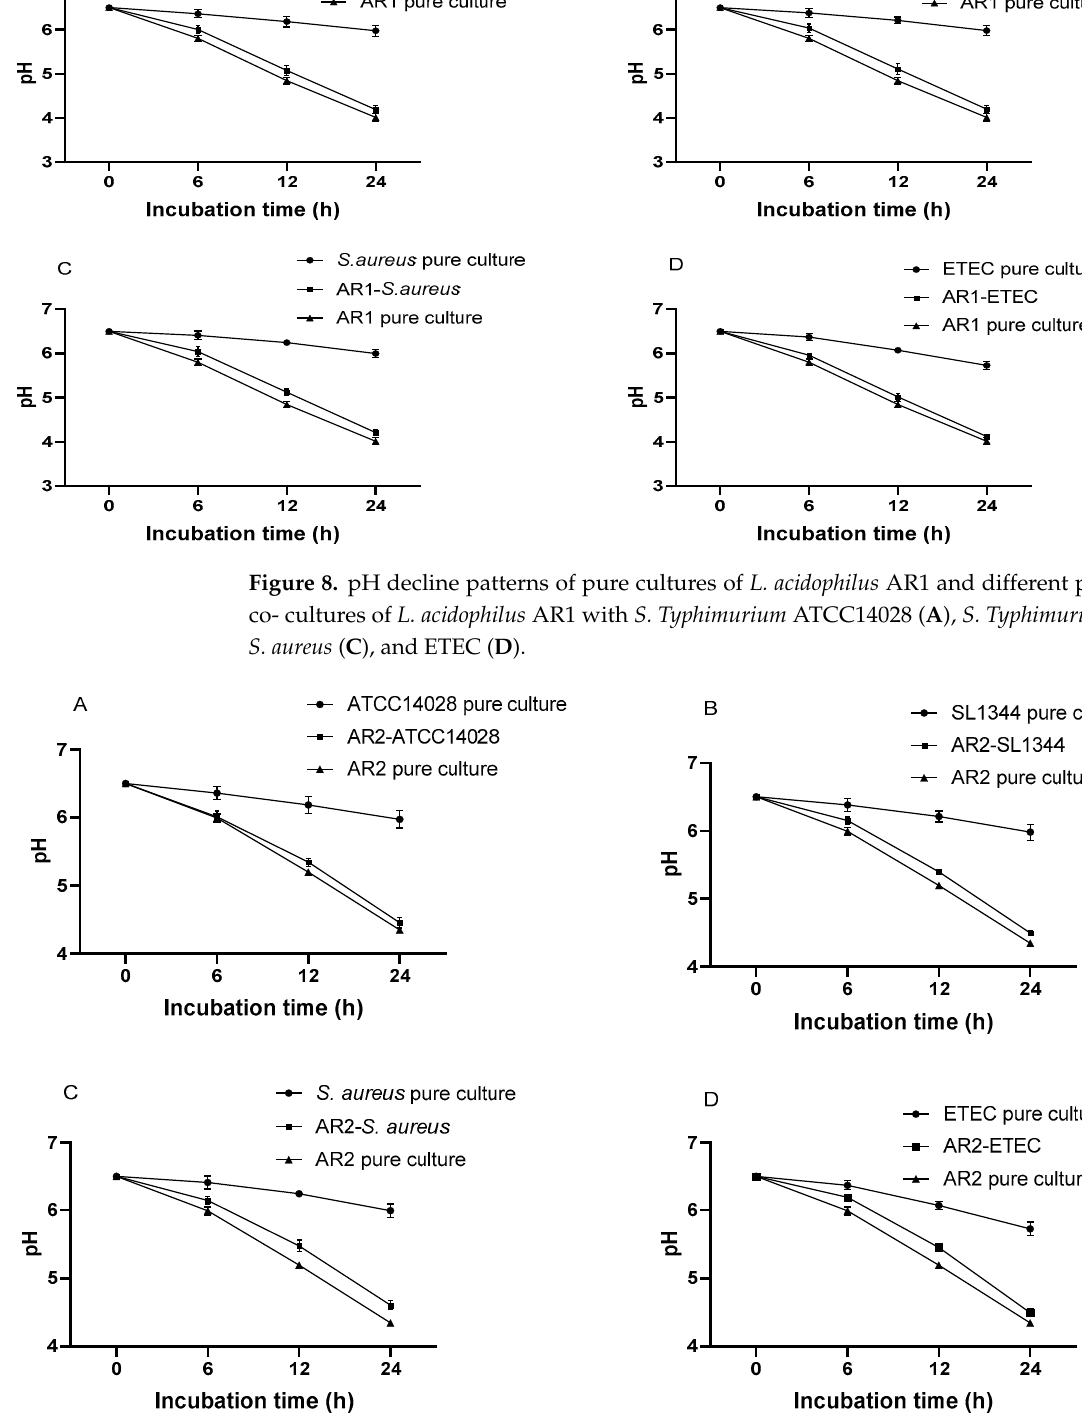
Figure 9. pH decline patterns of pure cultures of L. acidophilus AR2 and different pathogens, and co-cultures of L. acidophilus AR2 with S. Typhimurium ATCC14028 ( A ), S. Typhimurium SL1344 ( B ), S. aureus ( C ), and ETEC ( D ).